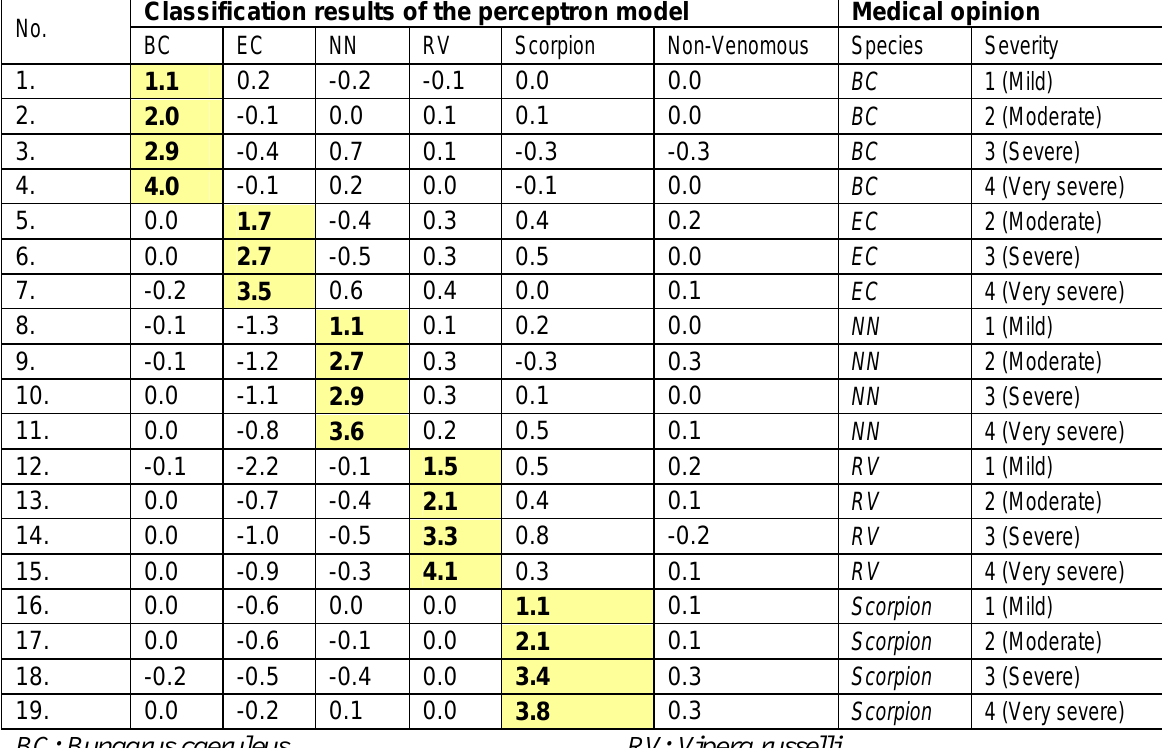
RV: Vipera russelli Non-Venomous: No venomous species detected Scorpion: Mesobuthus